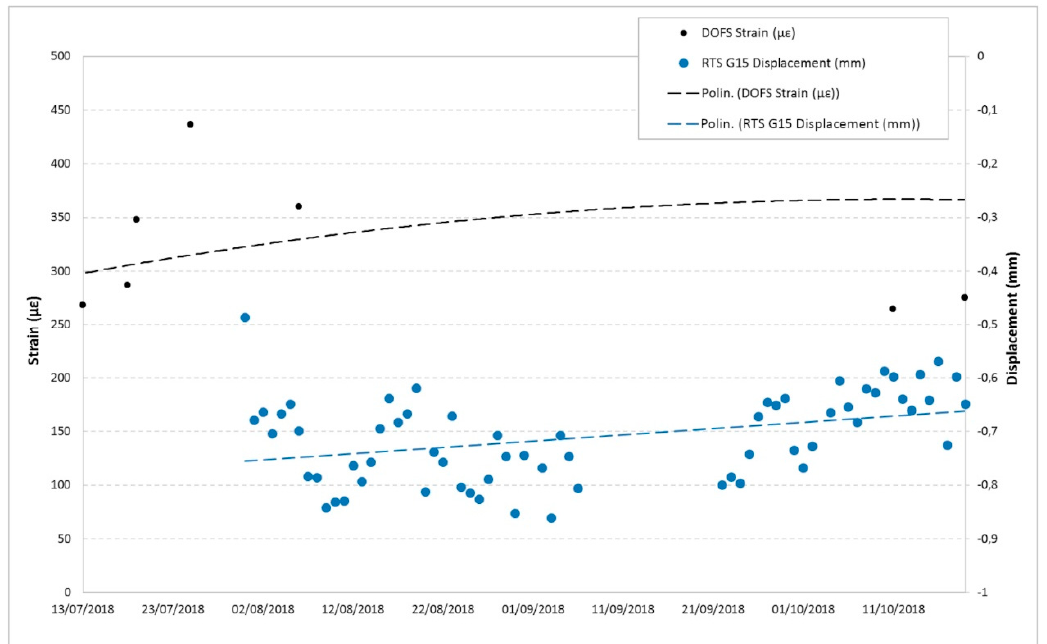
Figure 26. Comparison between the G15 RTS measuring point displacements (data interpreted according to a second order polynomial) and DOFS strain values in the same area.